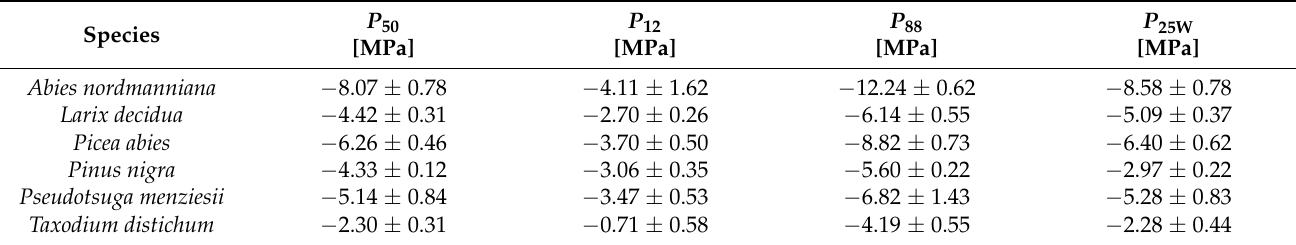
Table 3. Information on the hydraulic reference parameters P 50 , P 88 and P 12 as well as the proxy P 25W and their standard deviations; sample numbers (i.e., the number of hydraulic vulnerability curves) can be found in Table 1.